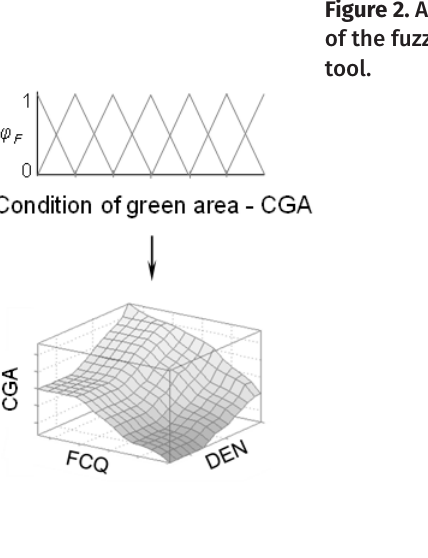
Figure 2. Architecture of the fuzzy-based